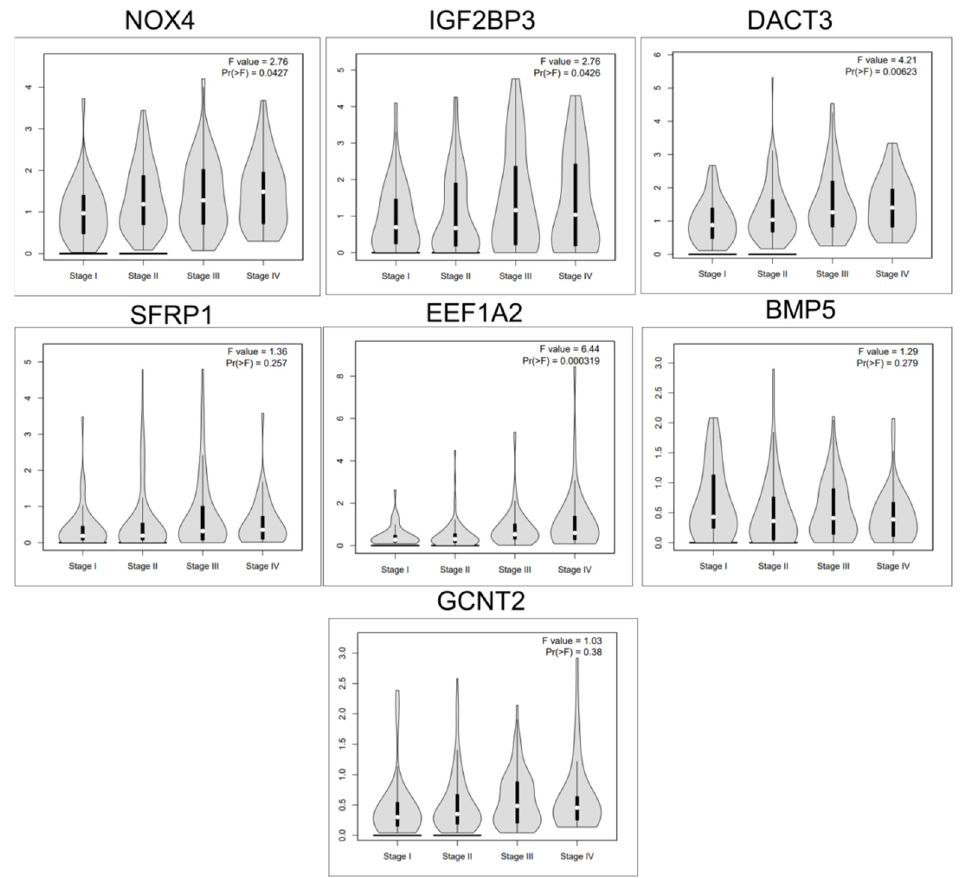
Figure 3. The expression level of NOX4, IGF2BP3, DACT3, SFRP1, BMP5, EEF1A2 and GCNT2 related to tumor stages in COAD, using GEPIA online tool.